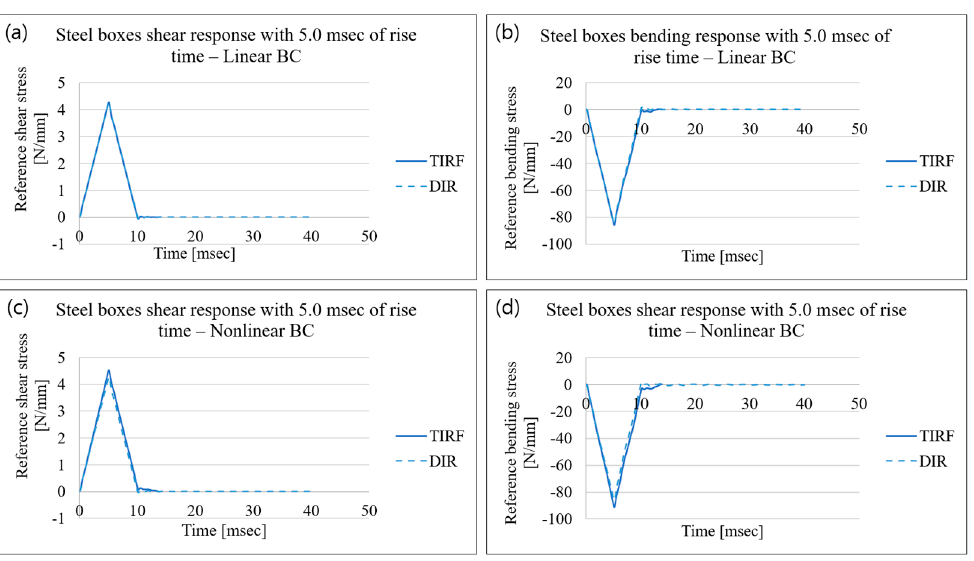
Figure 8. Reference shear and bending responses using TIRF and DIR for impact pressure of 5.0 ms of rise time: ( a ) Reference shear responses with linear boundary conditions, ( b ) Reference bending responses with linear boundary conditions, ( c ) Reference shear responses with nonlinear boundary conditions, and ( d ) Reference bending responses with nonlinear boundary